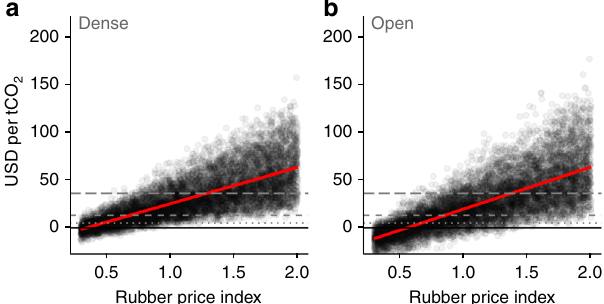
Fig. 5 Effect of rubber price on breakeven carbon prices in dense and open forests. The response of breakeven carbon price to rubber prices under the “ No timber logged ” scenario is shown for a dense and b open forests. Each dot represents the outcome of one model iteration. Grey dashed lines indicate real-world carbon prices, following Fig. 3. Red lines represent a linear model relating breakeven carbon price to rubber price index (with grey shaded SE, too narrow to be visible), where an index value of 1.0 is